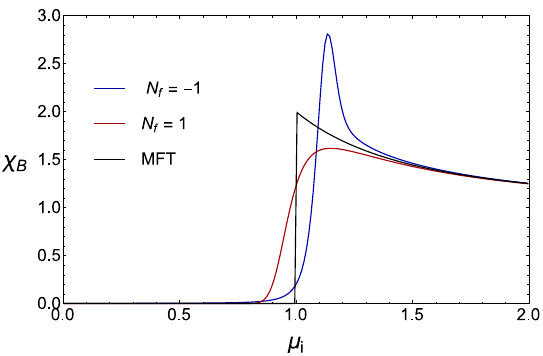
Figure 3 . The baryon number susceptibility as a function of the imaginary chemical potential, (cid:22) i for n = 100 and m = 3 = 10000. Results are shown for the fermionic partition function (red), the bosonic partition function (blue), and the mean (cid:12)eld limit of these partition